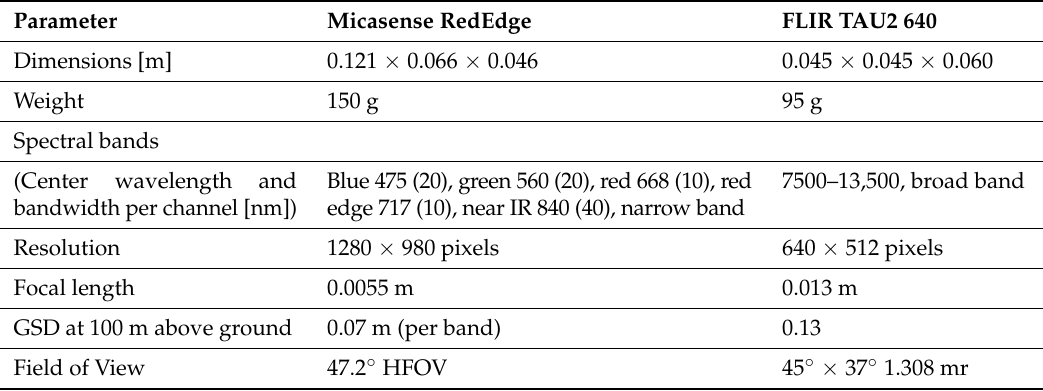
Table 1. Specification of the Micasense RedEdge and FLIR TAU2 640 camera systems. GSD: ground sampling distance; HFOV: horizontal field Of